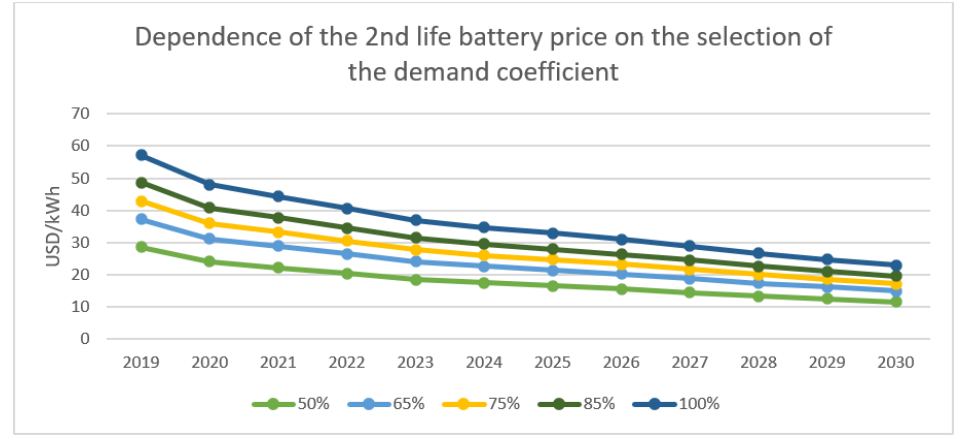
Figure 5. Dependence of the 2nd life battery price on the selection of the demand coefficient.